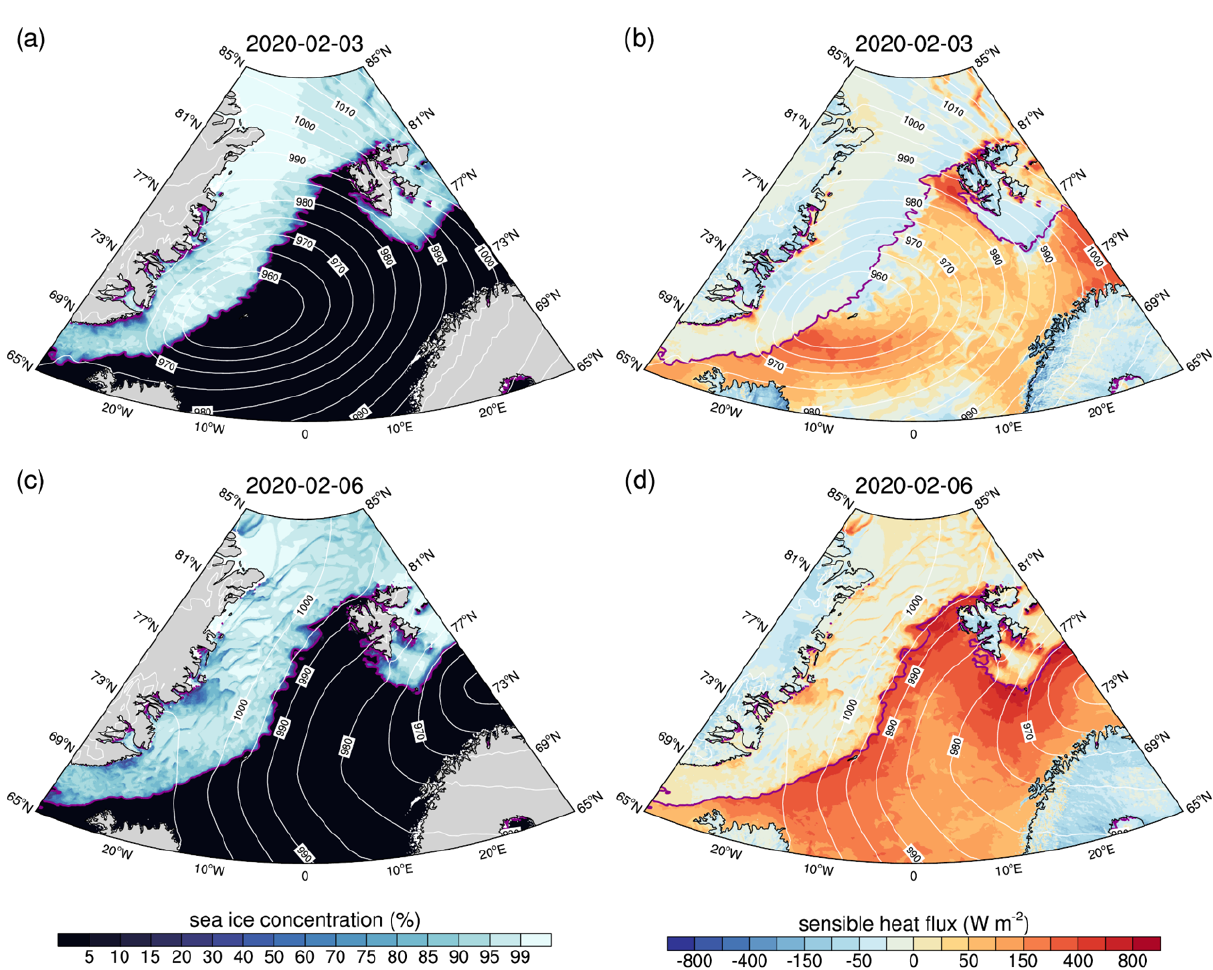
Figure 14. Sea ice breakup by a polar low and the effect on sensible heat flux in G_AO_2.5km. Daily mean values are shown. The white contour lines are for sea level pressure (hPa), and the magenta line is for the extent of the sea ice (15% concentration).